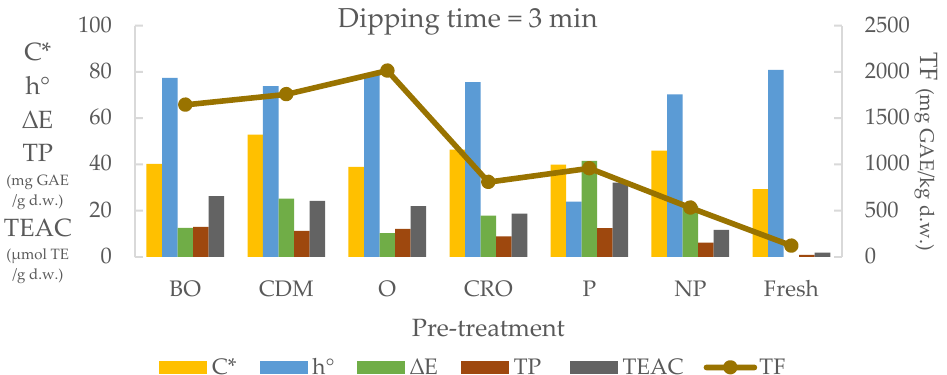
Figure 11. Effects of 3 min dipping time on quality parameters (tangerine ( Citrus deliciosa Mediter- ranean) (CDM); orange (O); bitter orange (BO); tangerine ( Citrus reticulate Owari) (CRO); pomegranate (P); non-pre-treatment (NP)).